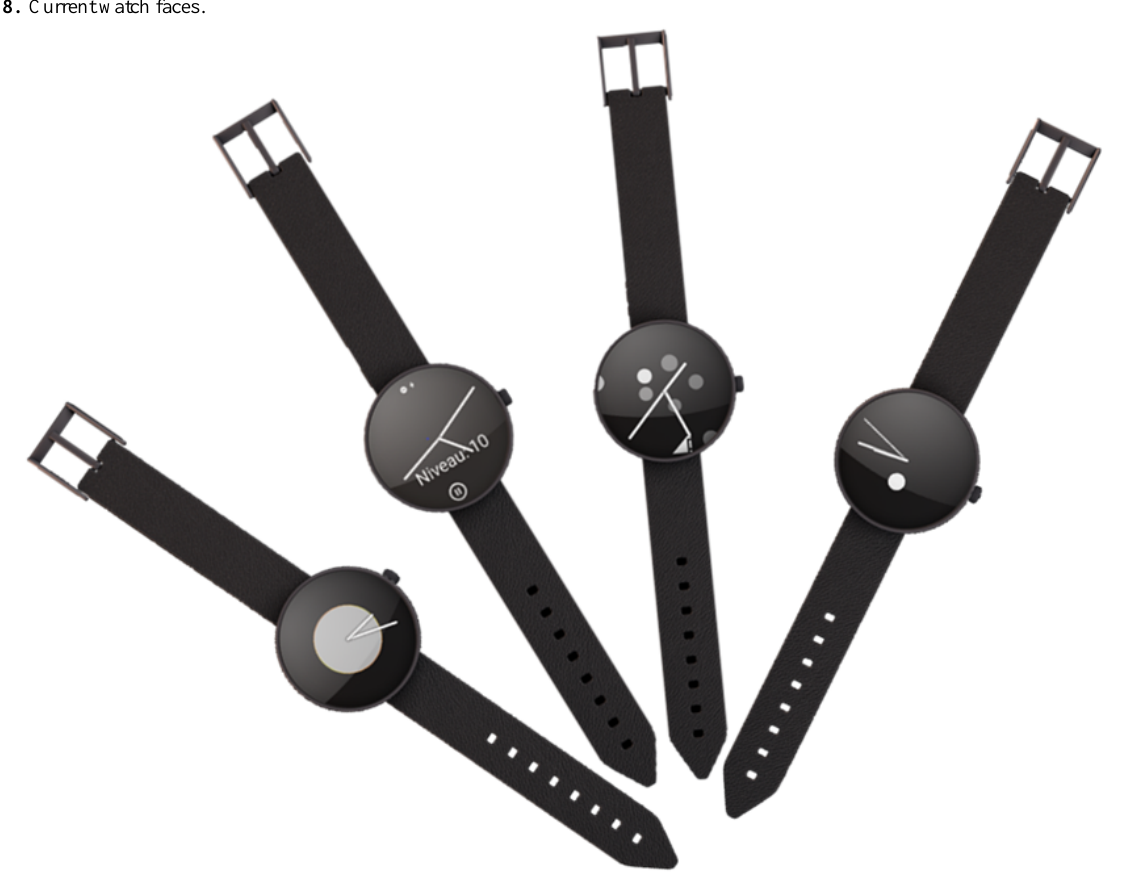
Figure 8. Current watch